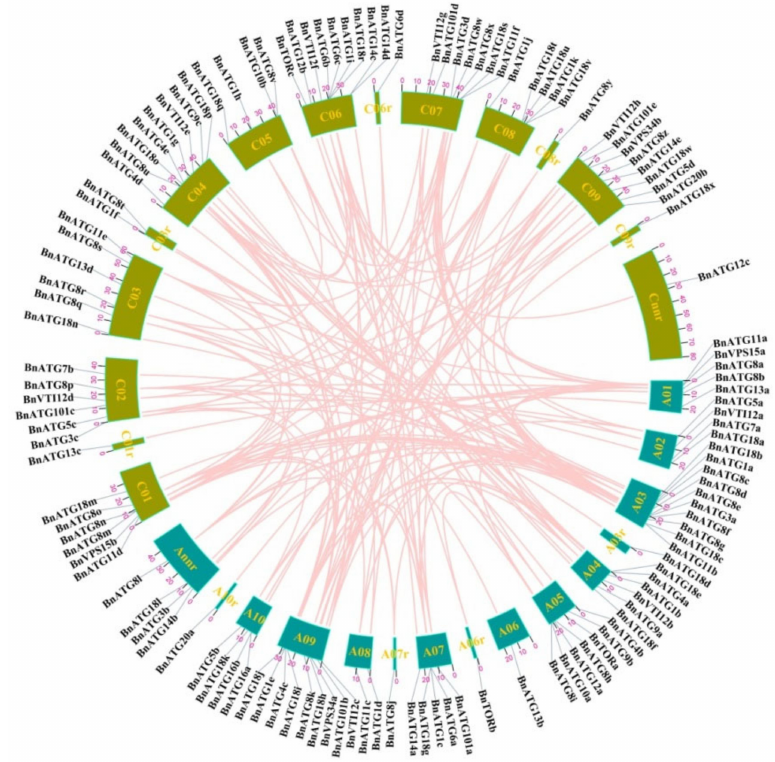
Figure 3. Chromosomal locations of B. napus autophagy-related genes. The location of genes on chromosomes and the duplication relationship between them were presented using TBtools. Chromosomes are represented by colored boxes. Pink curves connecting the genes indicate